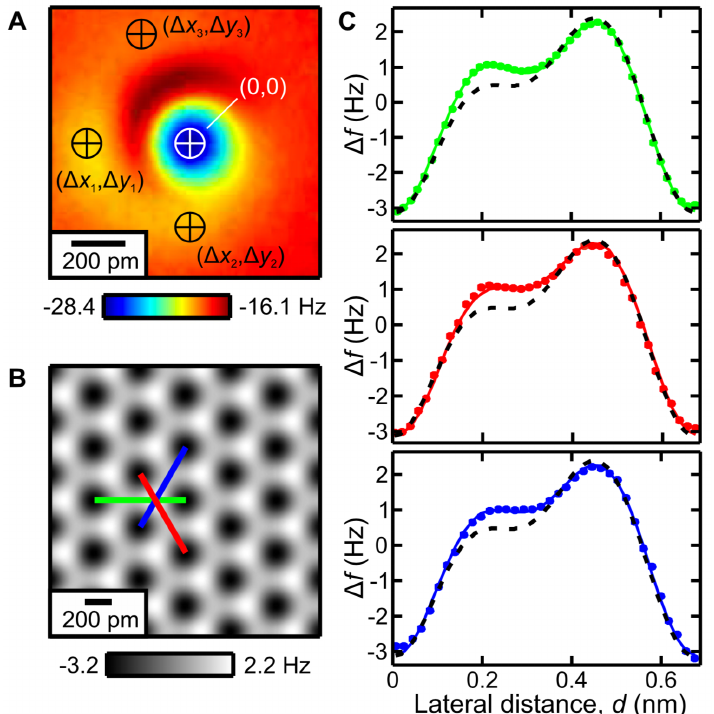
Figure 11. Refined tip apex description based on the COFI characterization. ( A ) COFI image of the single-atom metal tip.The white cross indicates the front atom at coordinates (0,0). Black crosses indicate second layer atoms (shifted with respect to the front atom by ( ∆ x i , ∆ y i ) used to refine the electrostatic calculation. Note: yellow color indicates a local minimum. ( B ) Calculated ∆ f image of CaF 2 (111) for the multi–atom tip model. ( C ) Line profiles along the three high–symmetry directions marked in ( B ). The calculation including four point charges (solid) matches the asymmetry of the experiments (dots) and gives a better agreement than the single point charge model (dashed). Adapted with permission from Institute of Physics from Figure 3 in